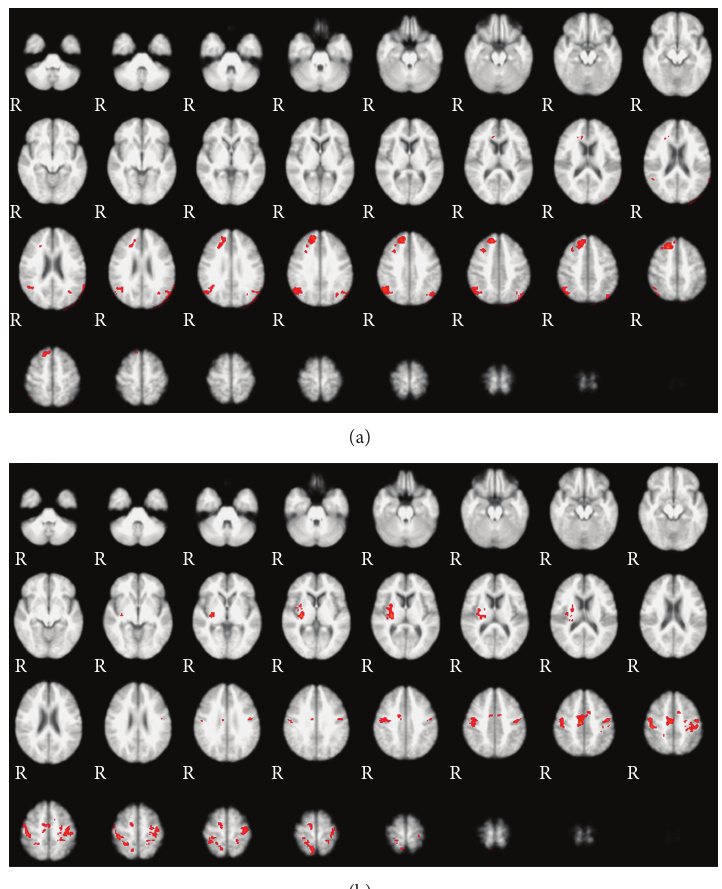
Figure 1: Radiological convention—right of the subject on the left of the figure. (a) Young > old: map of regions significantly more activated (in red) by the young population than by the older population in the RT task (CrossSquare). The right prefrontal (superior frontal gyrus) region is activated in the younger adults, as well as the angular gyrus (right more than left). (b) Old > young: map of regions significantly more activated (in red) by the old population than by the younger population in the RT task. There is significantly more right insular activation in the older population, as well as some larger bifrontal, supplementary motor areas and parietal networks (perirolandic). been used in aging studies and to apply it to our data